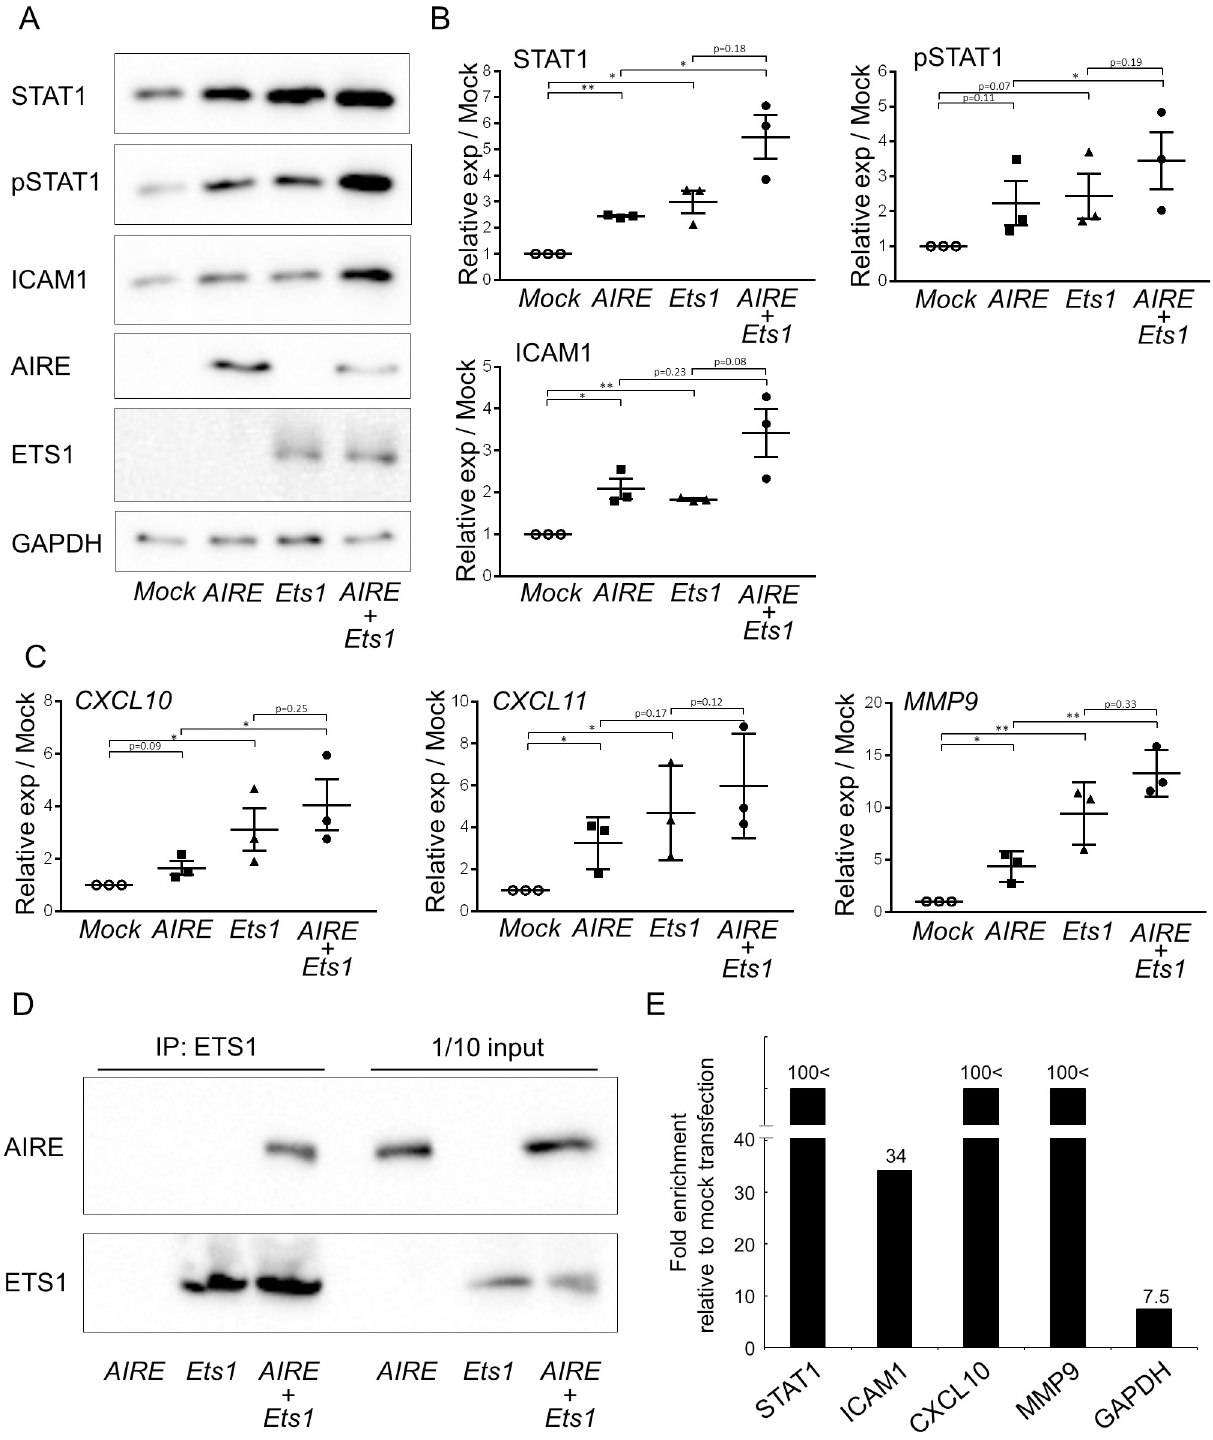
Fig 6. Physical and functional interaction of AIRE and ETS1. A) Expression of STAT1, pSTAT1, and ICAM1 in 293A cells 48 h after transfection with Flag-AIRE or/and ETS1 , or mock transfection. The blot shown is representative of three independent experiments. B) Densitometric analysis of data in A). Data are shown as the mean ± SEM of technical triplicates and are representative of three independent experiments. � P < 0.05, �� P < 0.01, by ratio t-test. C) Relative gene expression of CXCL10 , CXCL11 , and MMP9 in comparison to mock transfection as revealed by real-time PCR. Data are shown as the mean ± SEM of triplicate wells and are representative of two independent experiments. � P < 0.05, �� P < 0.01, by ratio t-test. D) Immunoprecipitation and western blot analysis of ETS1 and AIRE. Formaldehyde crosslinking was performed prior to lysis. The lysates were sonicated to shear the DNA.